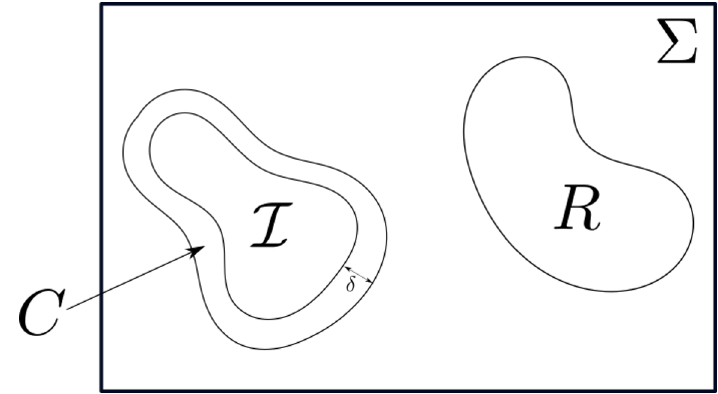
Figure 4 : Representative cartoon of the subregions of time slice Σ used in the proof of